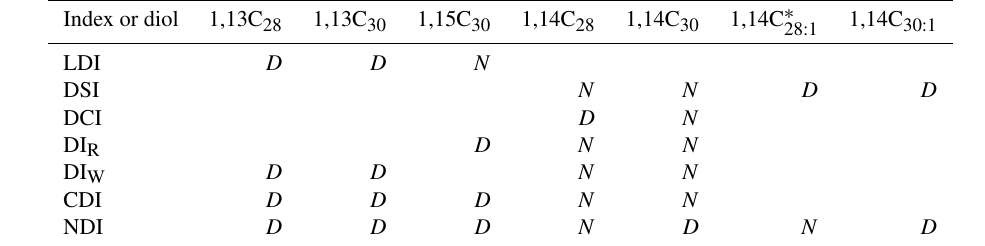
Table 2. Composition and position of the diols in the